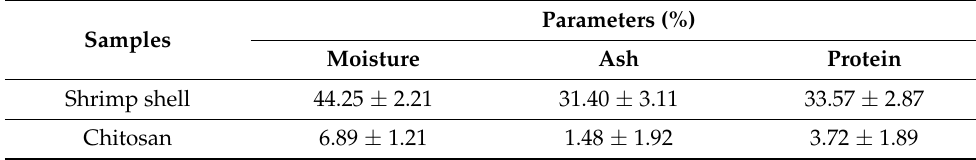
Table 2. Chemical composition of shrimp shell and CH.